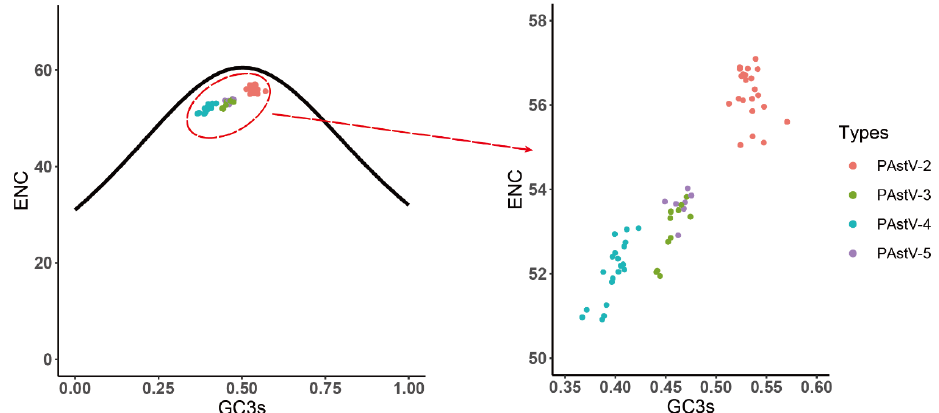
Figure 5. ENC plot analysis of the complete coding genomes of PAstV. The ENC plot displayed the relationships between ENC and GC content at the third codon position (GC3s) of protein-coding sequences. The curve represents the expected ENC values for all GC3 compositions. PAstV-2, PAstV-3, PAstV-4, and PAstV-5 strains are represented in orange, green, blue, and purple,